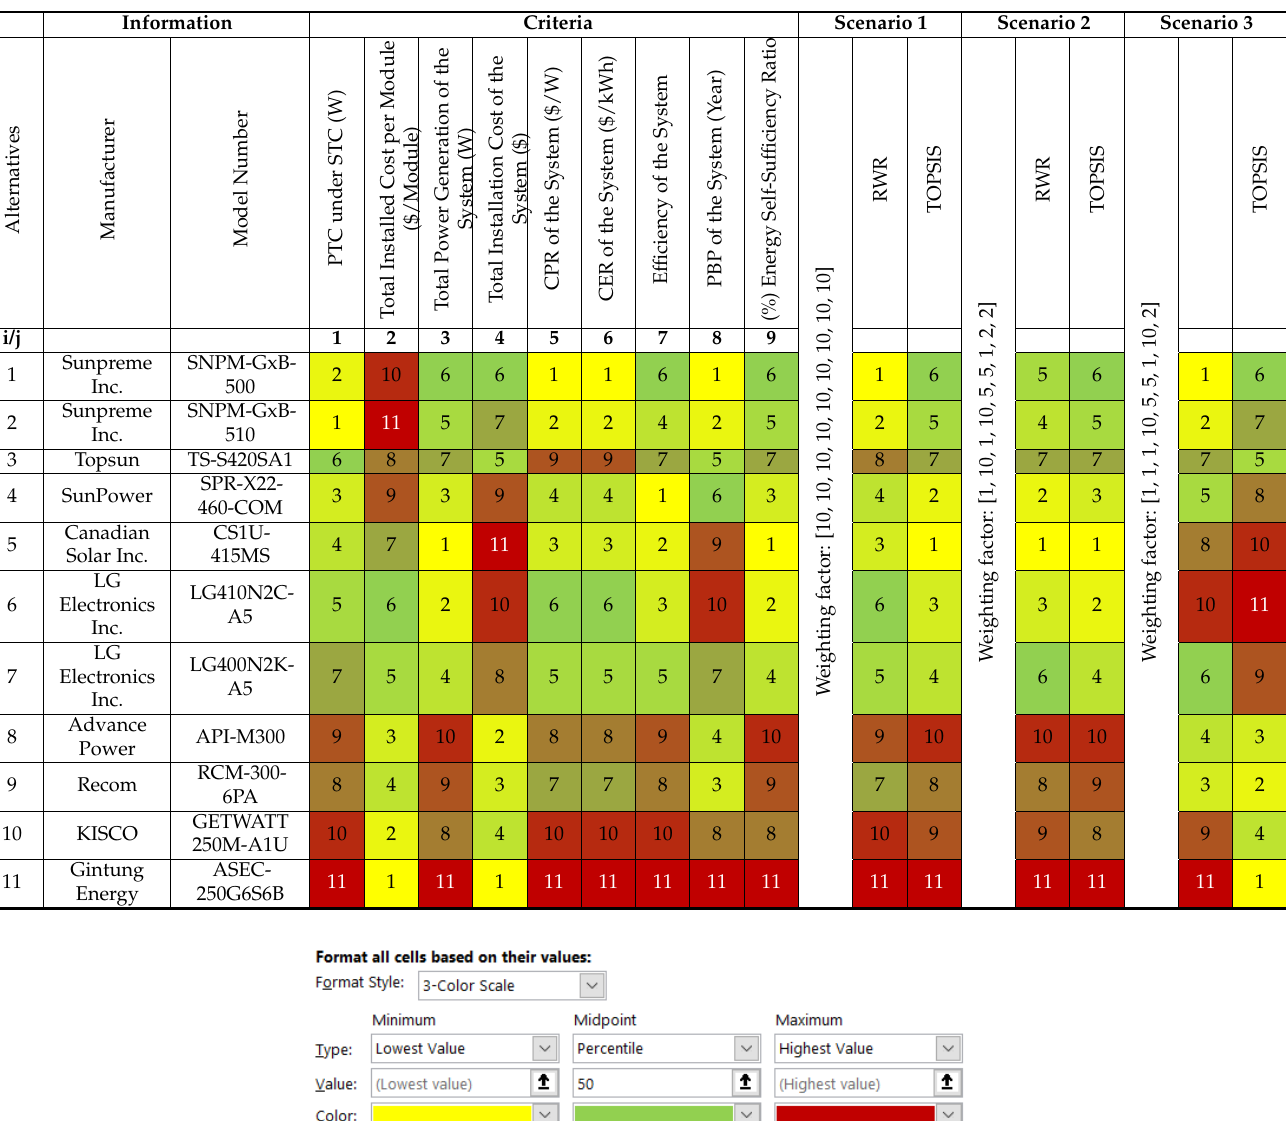
Table 5. Comparison between rank-weigh-rank and TOPSIS algorithms for the three aforementioned scenarios. Information Criteria Scenario 1 Scenario 2 Table 4. Three scenarios with different weighting factors are used to compare RWR and technique for order of preference by similarity to ideal solution (TOPSIS) algorithms.